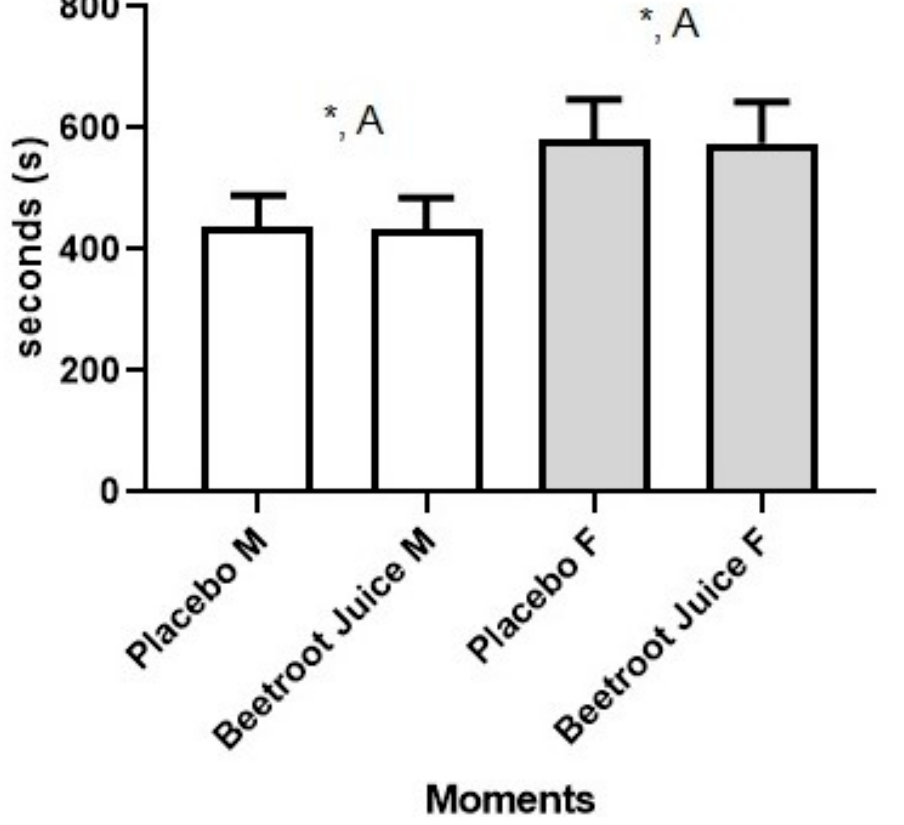
Figure 1. Two km completion times in nitrate-rich beetroot juice and nitrate-depleted beetroot juice (placebo) conditions. Data presented as mean ± standard deviation. * means statistical differences between beetroot juice and placebo ( p < 0.05); A means significant gender ( p < 0.05).